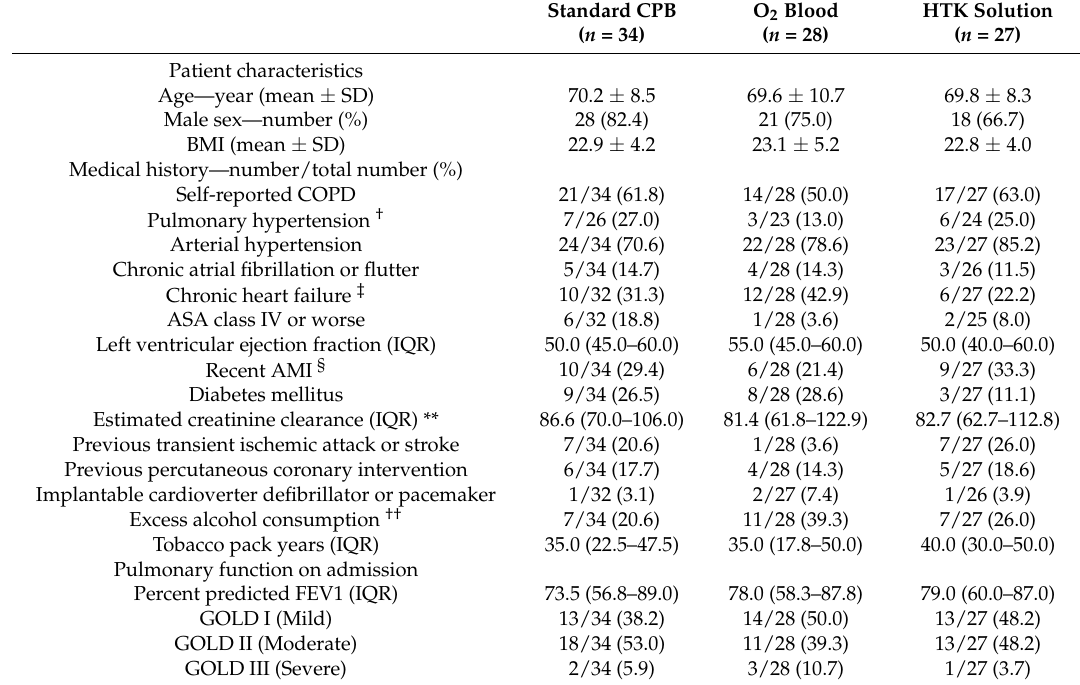
Table 1. Clinical and procedural characteristics (per-protocol